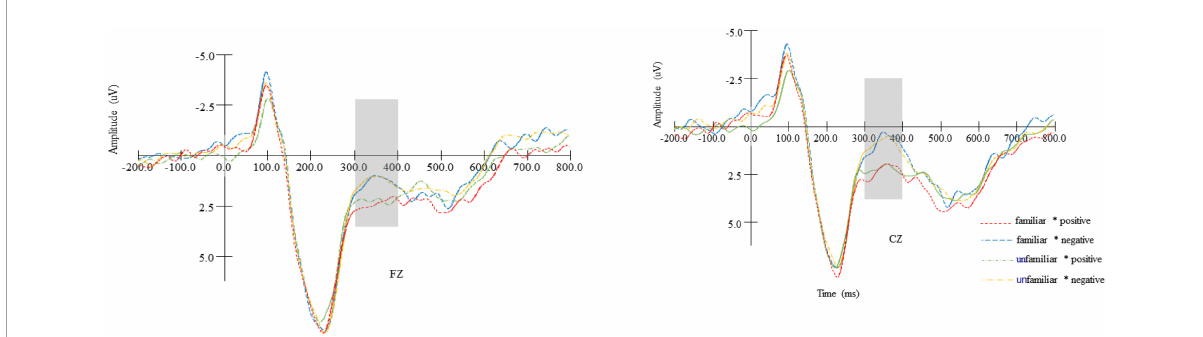
FIGURE4 The N400 amplitude comparison of different combinations for brand familiarity (familiar vs. unfamiliar) and online reviews (positive vs. negative) in representative electrodes (FZ and